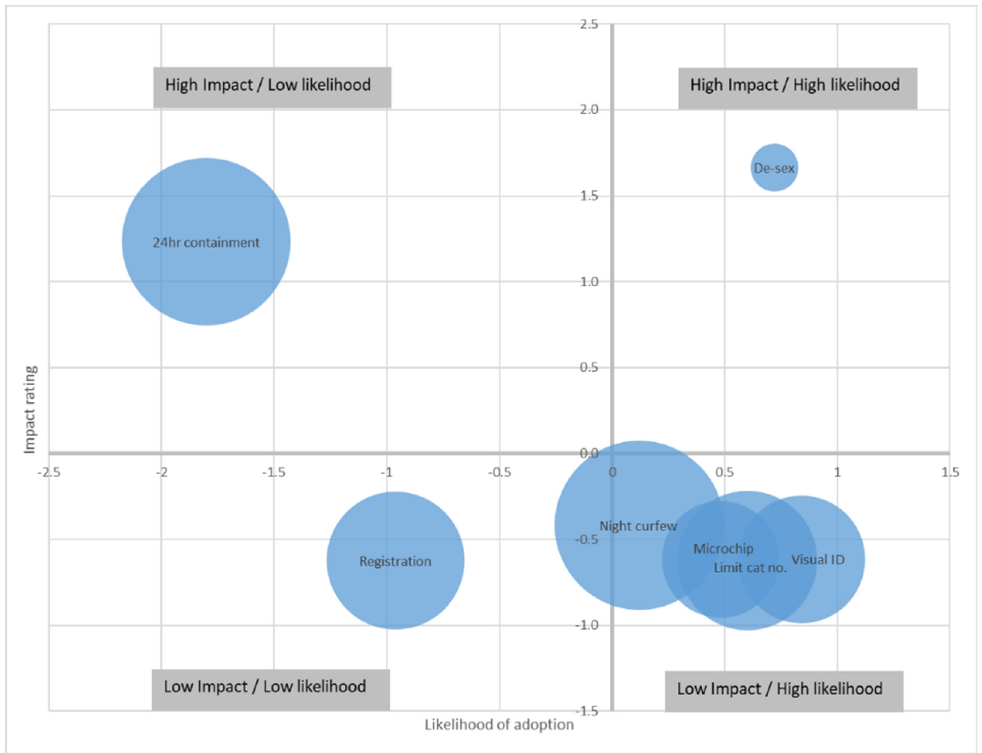
Figure 1. Impact–Likelihood prioritisation matrix ranking cat owner behaviours based on standardised values for effectiveness of behaviour for reducing the number of free-roaming cats (impact) and likelihood of behaviour adoption (after [56]). Size of circles indicate proportion of target population not currently engaging in the behaviour.